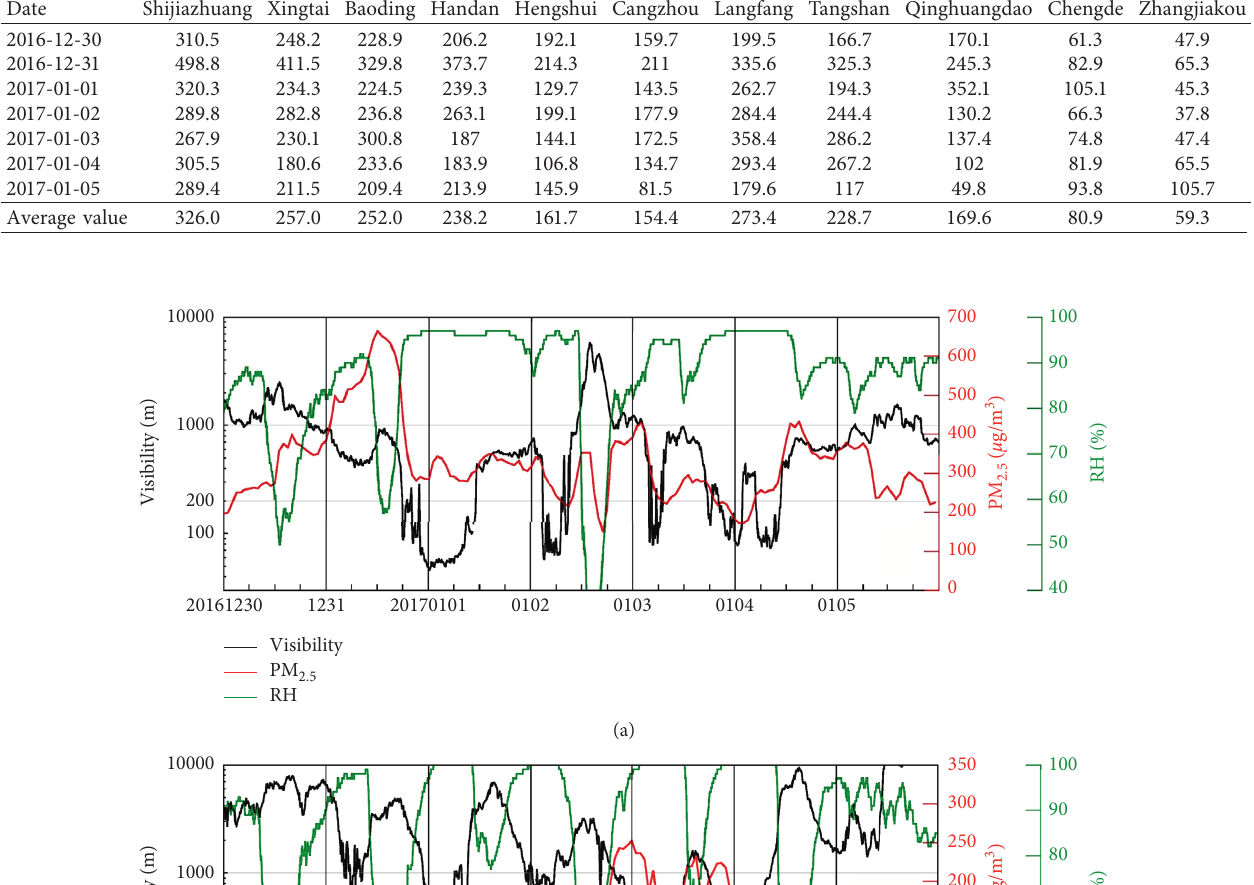
Table 3: Daily mean concentrations of PM